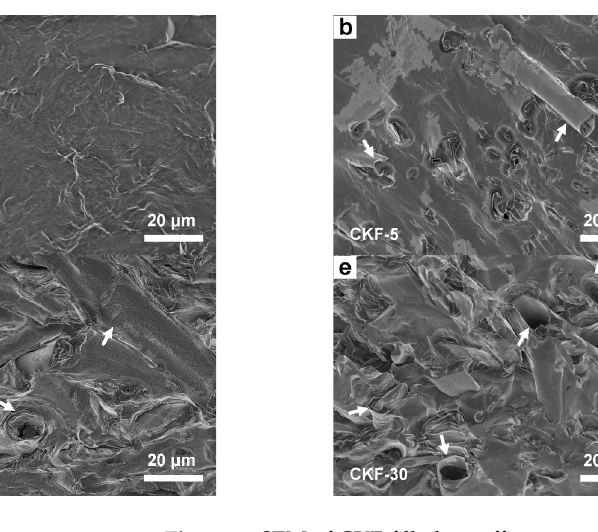
Figure 4. SEM of CKF-filled paraffin composites with different filler loading.